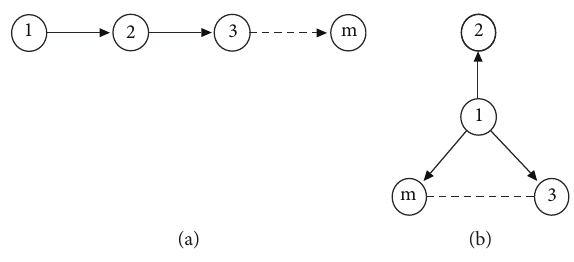
Figure 4: A path graph and a star